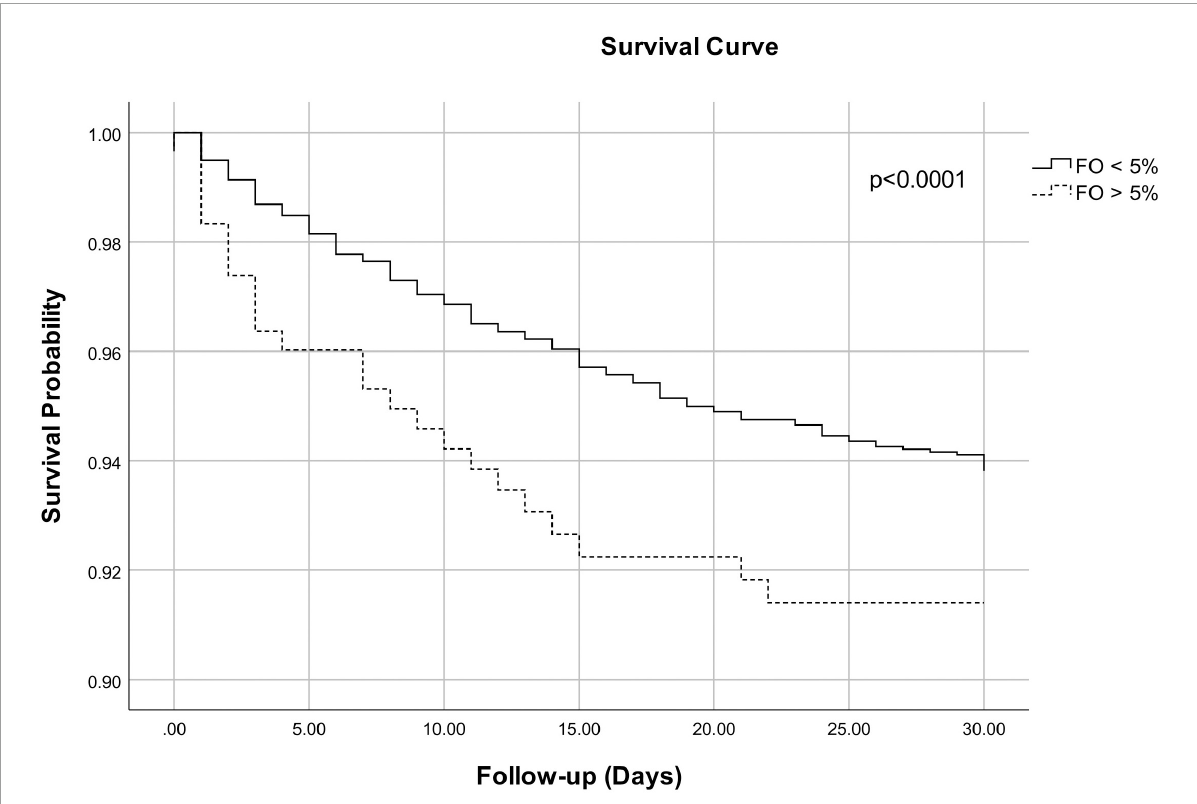
FIGURE2 Adjusted Cox regression survival curves for 30-day mortality for patients with fluid overload < 5% and fluid overload > 5% at intensive care unit (ICU) discharge. The curves are adjusted for age, chronic liver disease, cancer, prior respiratory disease, cardiac surgery at admission, baseline creatinine, baseline bicarbonate, baseline lactate, and the need for a cardiac assist device after ICU admission. Log likelihood test p <